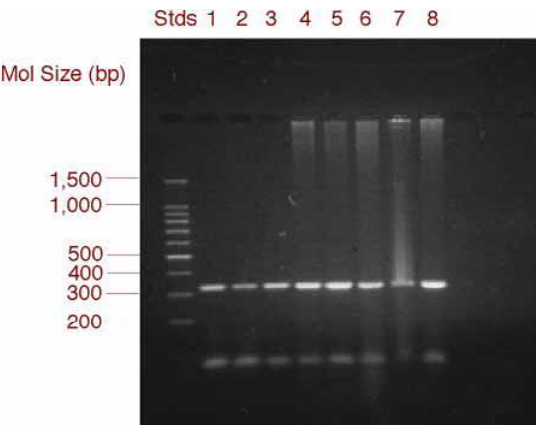
Figure 2. Effect of CAEV infection in vitro on the expression of a 324 bp fragment of MIP-1 α mRNA in peripheral blood mononuclear cells of goats. Total RNA extracted from PBM cells was subjected to RT-PCR using goat specific primers. Samples were electrophoresed on a 2% agarose gel, stained with ethidium bromide and photographed utilizing ultraviolet transillumination. Stds: mol. size marker; Lanes 1-4: control PBMC isolated from uninfected goats; Lanes 5-8: PBMC isolated from CAEV- infected goats.